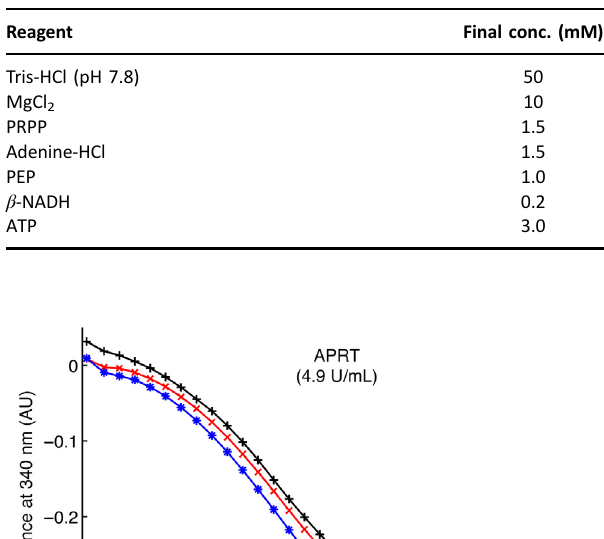
Table 8. Reagents for XGPRT assay.